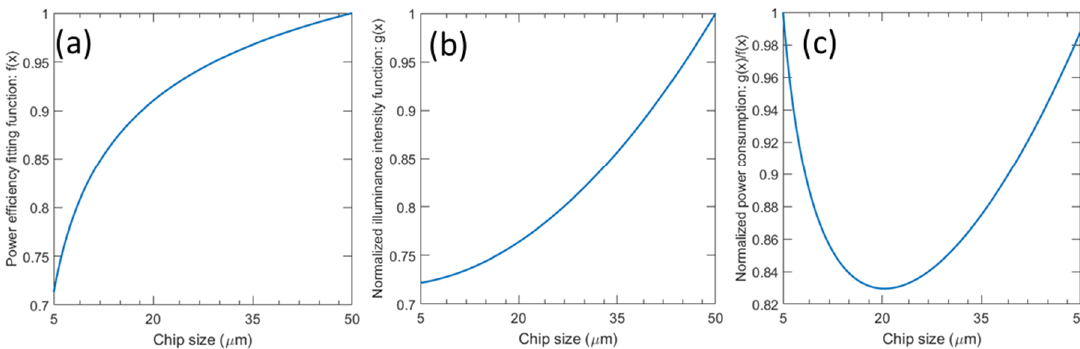
Figure 13. Normalized ( a ) power efficiency fitting function f(x), ( b ) luminance intensity function g(x), and ( c ) power consumption function g(x)/f(x) at different LED chip sizes.